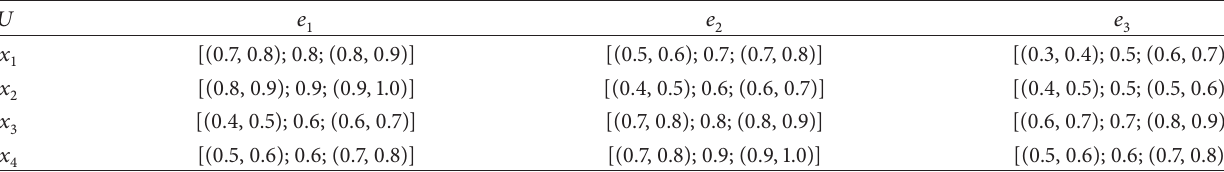
Table 3: Evaluation value of the first year.